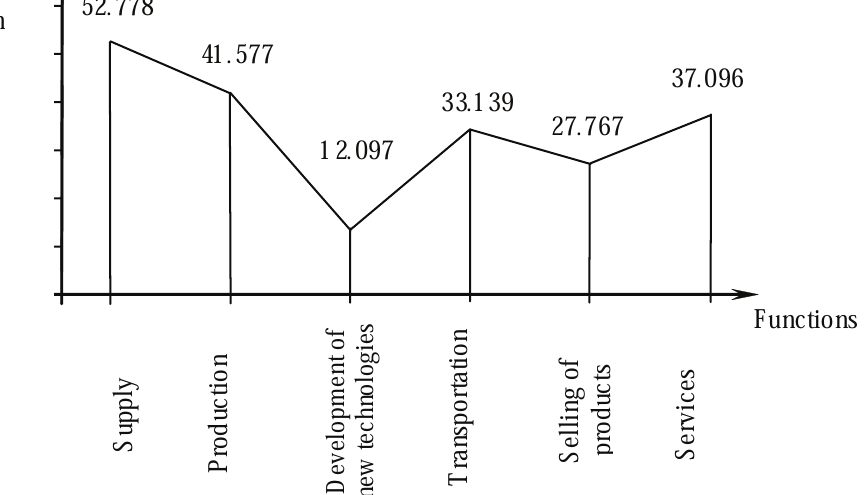
Fig. 4. The level of production functions’ cooperation of the considered